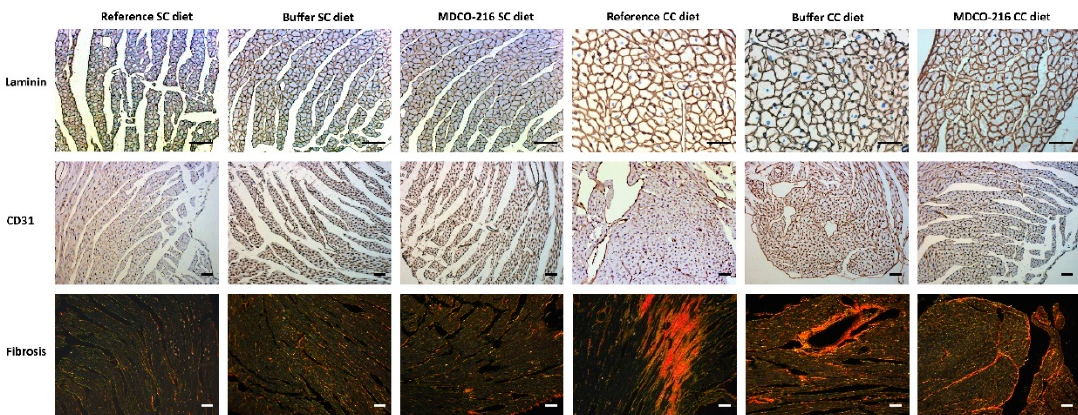
Figure 7. Immunohistochemical and histochemical analysis of the myocardium of reference, buffer, and MDCO-216 SC diet and CC diet mice. Representative photomicrographs show laminin-stained cardiomyocytes, CD31-positive capillaries, and Sirius-red-stained collagen. Scale bar represents 50 μ m.